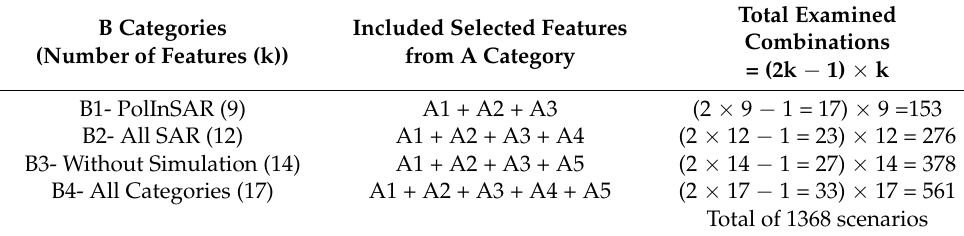
Table 5. Features used in different scenarios of B